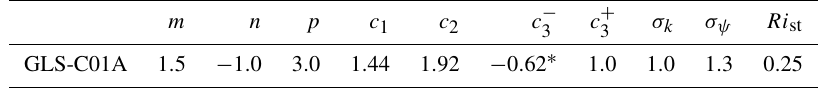
m n p c 1 c 2 c −